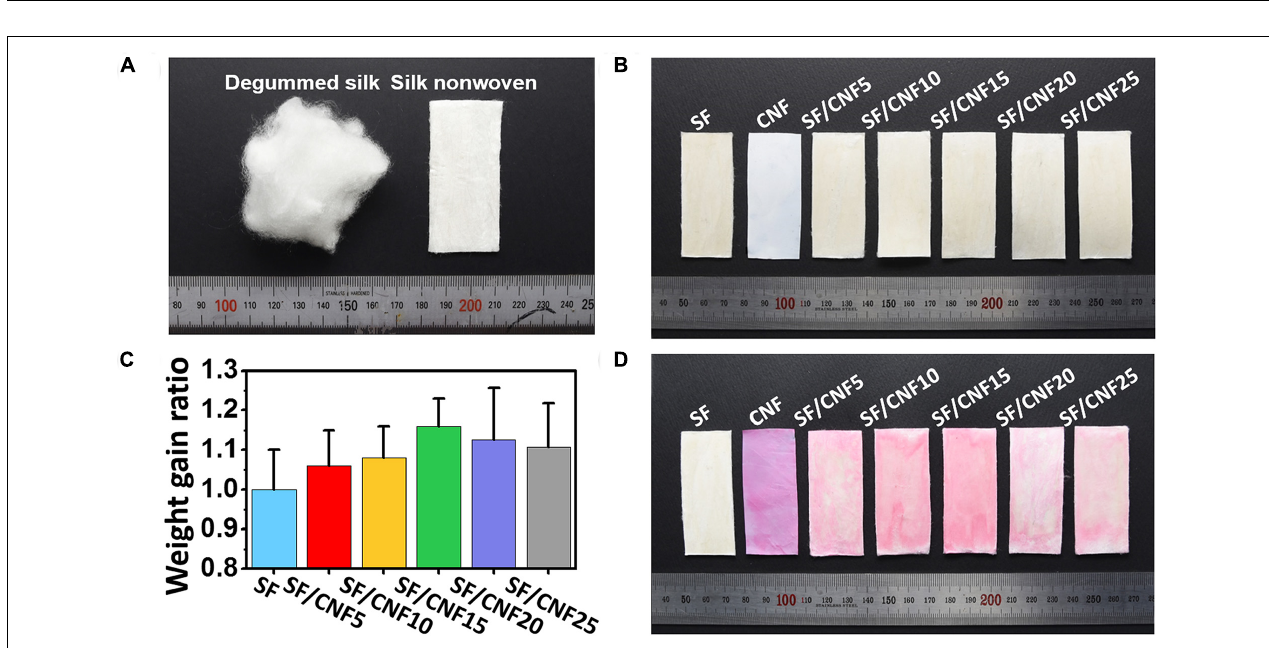
FIGURE 2 | Effect of CNF addition on the visual inspection of SF/CNF composites. Optical images of degummed SF fibers and prepared SF nonwoven without heat treatment (A) , hot-pressed SF/CNF composites (B) , weight gain ratio of SF/CNF composites (C) , and optical images of Direct Red 80 dyed SF/CNF composites (D) .